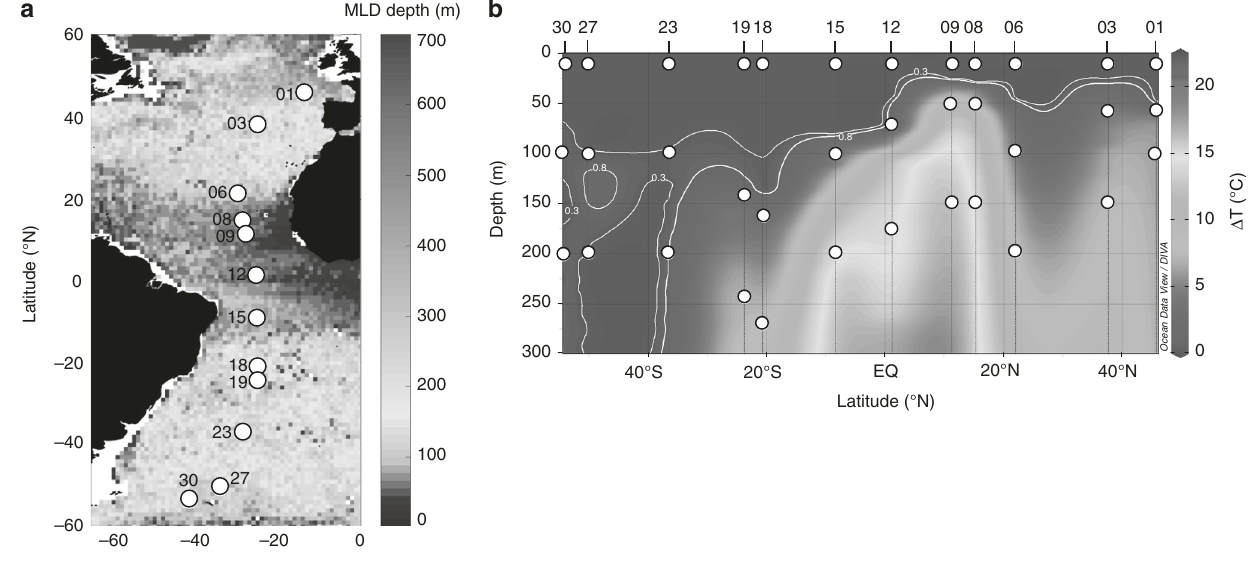
Fig. 1 Sampling locations for microplastics. a Sampling sites (numbered white circles) superimposed on a climatology of maximum monthly mixed layer depth (MLD, m) in the Atlantic Ocean compiled using Argo pro fi les 79,80 b Latitudinal section showing sampling locations (numbered) for microplastics (white circles) in the water column in relation to the depth of mixed layer, de fi ned as an absolute change in temperature ( Δ T (°C)) with respect to an approximately uniform region of temperature at 10 m below the ocean surface 25 . Vertical pro fi les of temperature were collected at each station prior to the deployment of SAPs (ref. 23 ). Isotherms (white contours) of Δ T = 0.8 °C marked the base of the mixed layer at stations 01 to 19. Due to intense mixing at stations 23, 27, and 30, the fi xed temperature criterion was lowered to Δ T = 0.3 °C (ref. 25